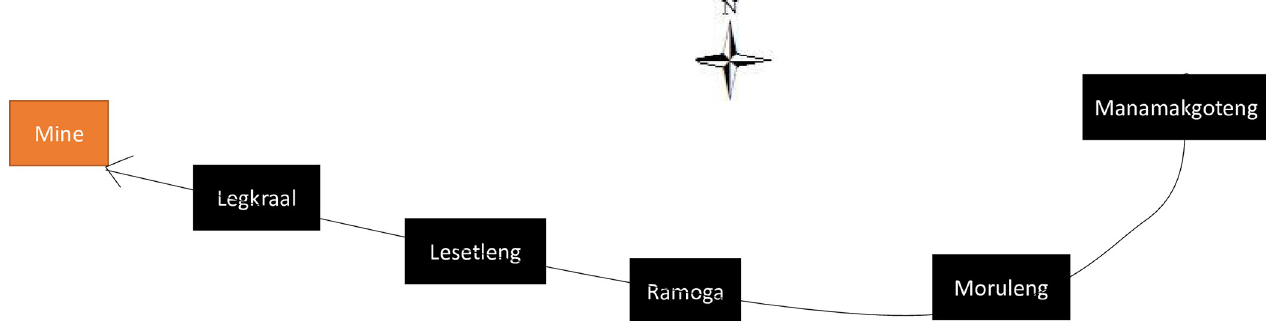
Fig 1. Spatial pattern of the positions of the five targeted villages for this study. In black are the positions of villages and in orange the position of the mine. The arrow indicates the direction from the furthest to the closest village to the mine location.